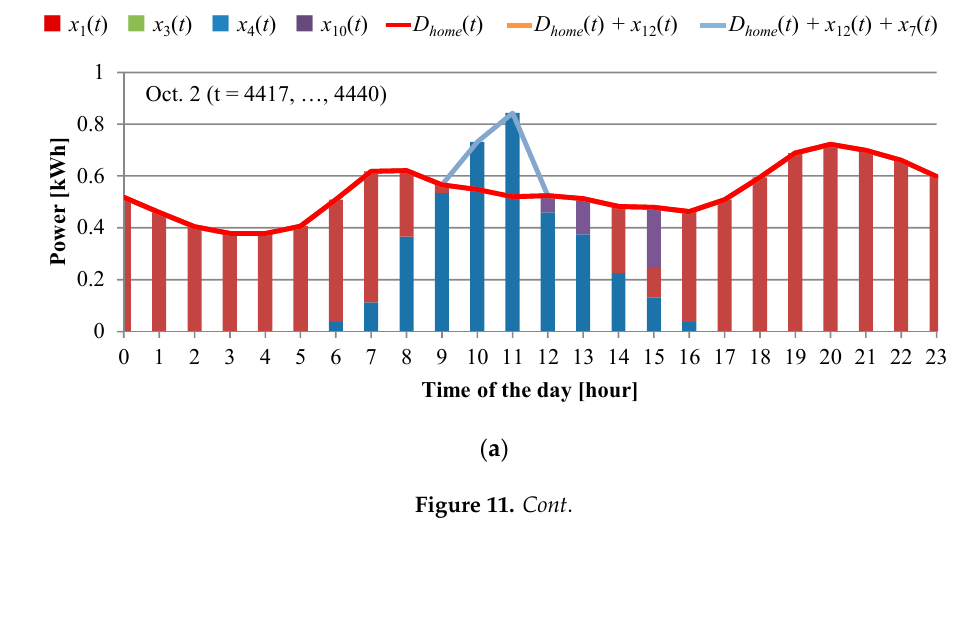
Figure 10. Optimized energy flow in case 4 on the day with large amount of PV power generation ( a ) residential supply-demand balance and ( b ) operation schedule of EV battery with vehicle-to-home (V2H).